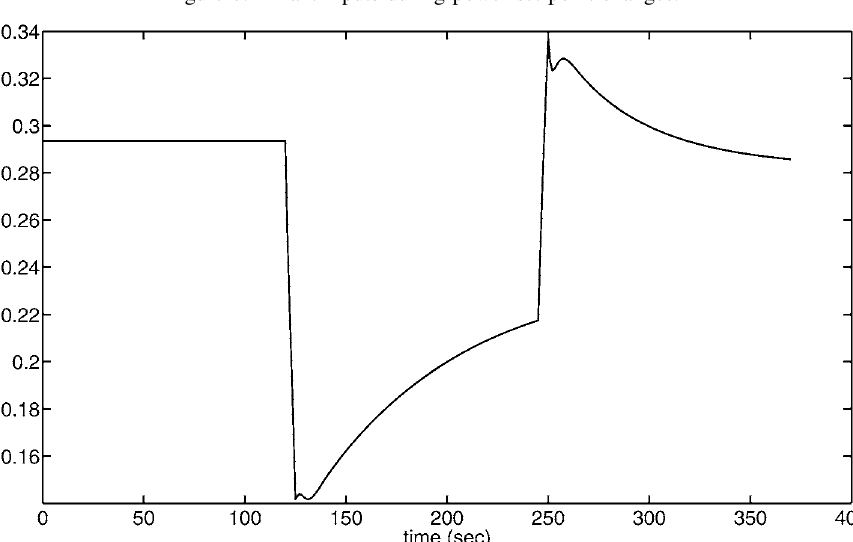
Figure 7. Plant inputs during power set point changes.